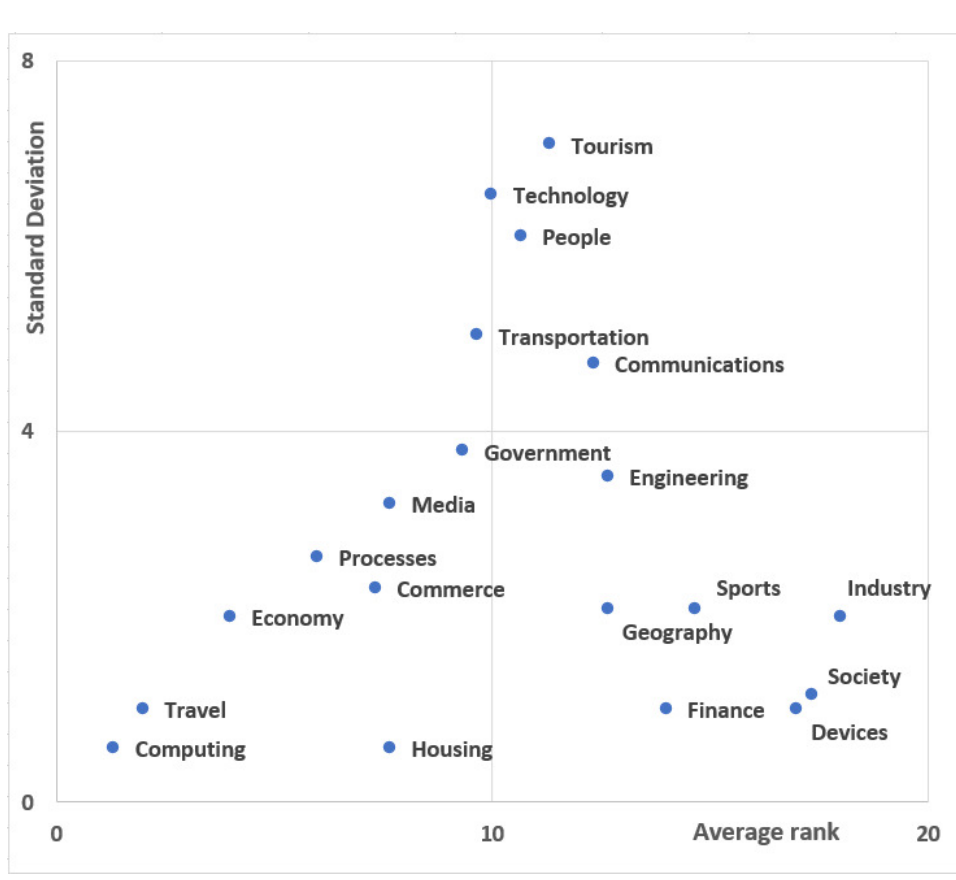
Figure 8. Quadrant of relevance variation for average ranking of each smart city area.